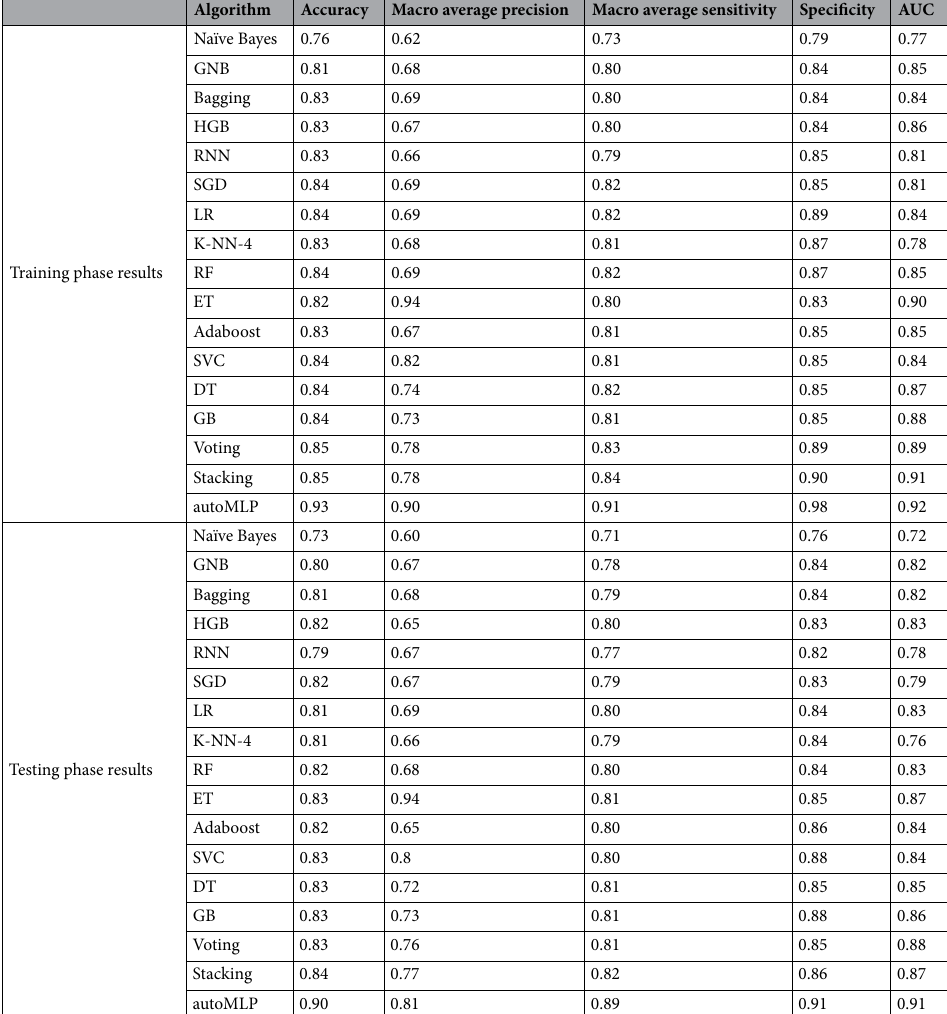
Table 2. Performance metrics of different classification algorithms applied on oversampled